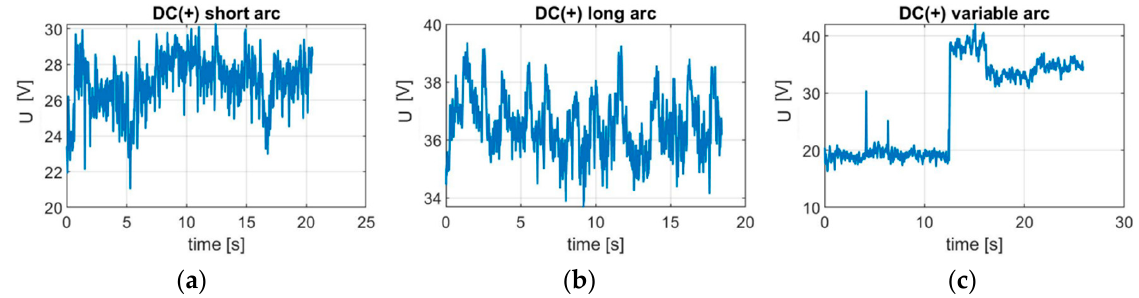
Figure 11. Voltage change caused by arc length variations for the DC(+) polarity: ( a ) stable—short arc (s2); ( b ) unstable—